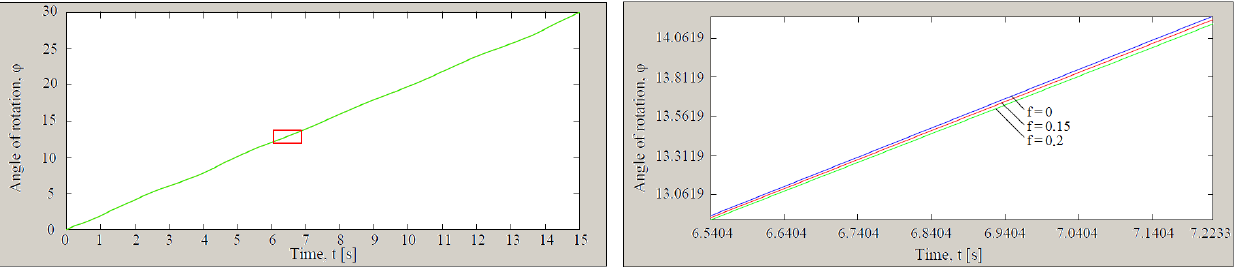
Figure 12. Dependence of rotation angle of the driving link (engine shaft) on time at different values of the coefficient of sliding friction f and for value of coefficient of rotational friction k = 0.